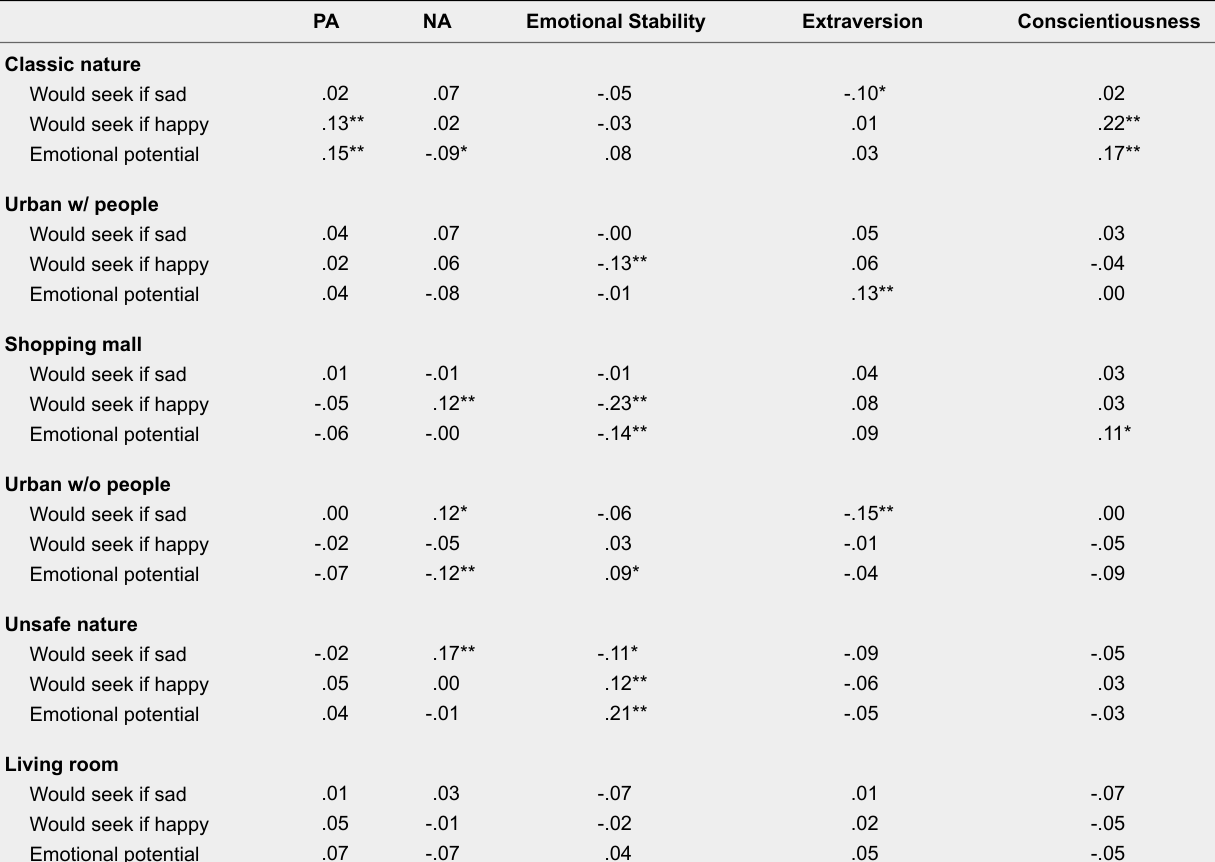
Correlations Between Emotional Potentials and Intentions to Seek Different Environments, and Mood/Personality ConscientiousnessExtraversionEmotional